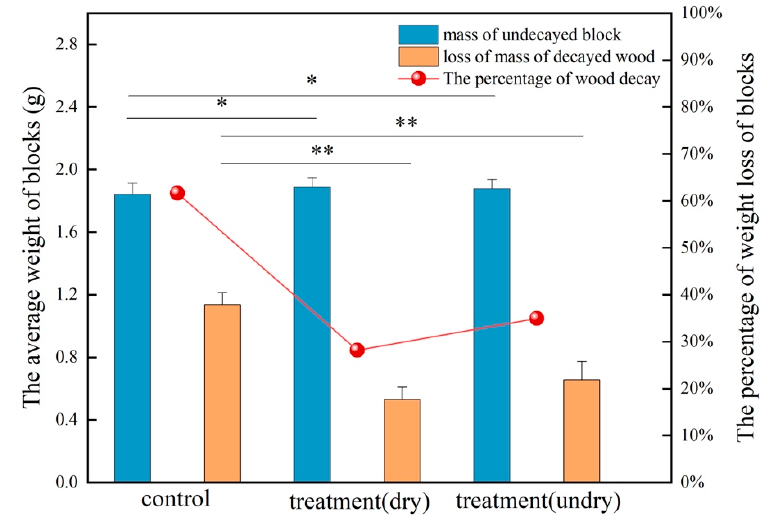
Figure 7. The degree of wood block decay in the treatment group and control group. * indicates no significant difference and ** indicates a significant difference.